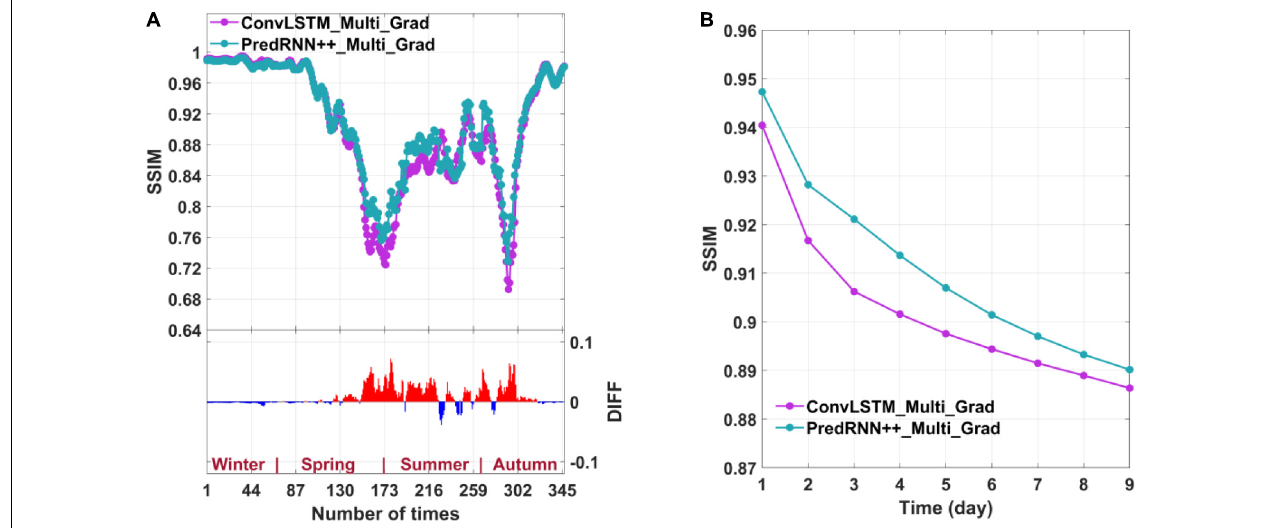
FIGURE 9 | Average SSIM for the ConvLSTM and PredRNN++ multi-factor models for 347 predictions (A) ; Average SSIM of the nine consecutive days of prediction (B) . The DIFF in the bar graph is obtained by subtracting the model of ConvLSTM from the model of PredRNN++.